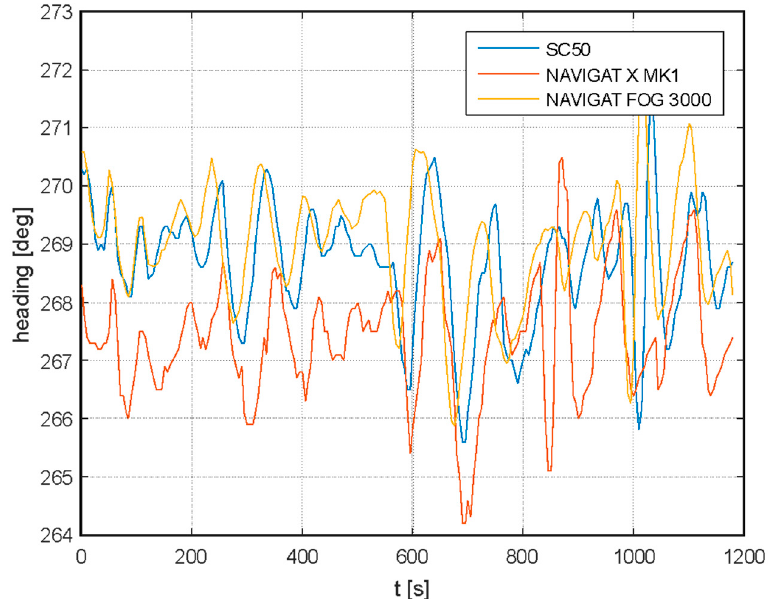
Figure 4. Example of registered headings from a classic gyrocompass (NAVIGAT X) fiber-optic gyro (NAVIGAT FOG 3000) and satellite compass FURUNO SC50 [18].